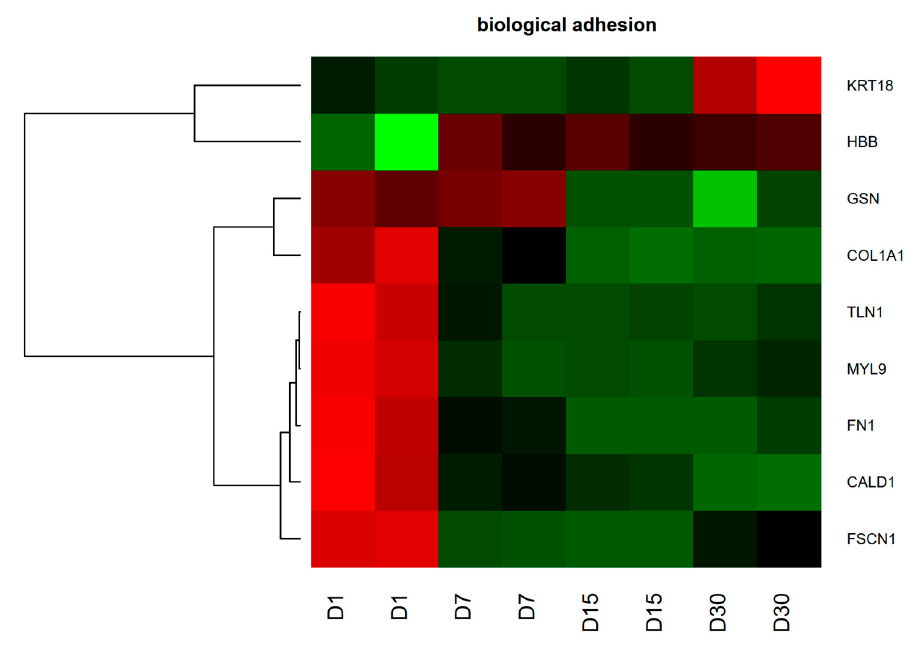
Figure 5. Heatmap representation of differentially expressed genes belonging to “biological adhesion” GO BP term. Microarray signal intensity values for each gene were adapted to Row Z-Score scale ranging from –2 (the lowest expression) to +2 (the highest expression) and reflected by red and green colors, respectively.